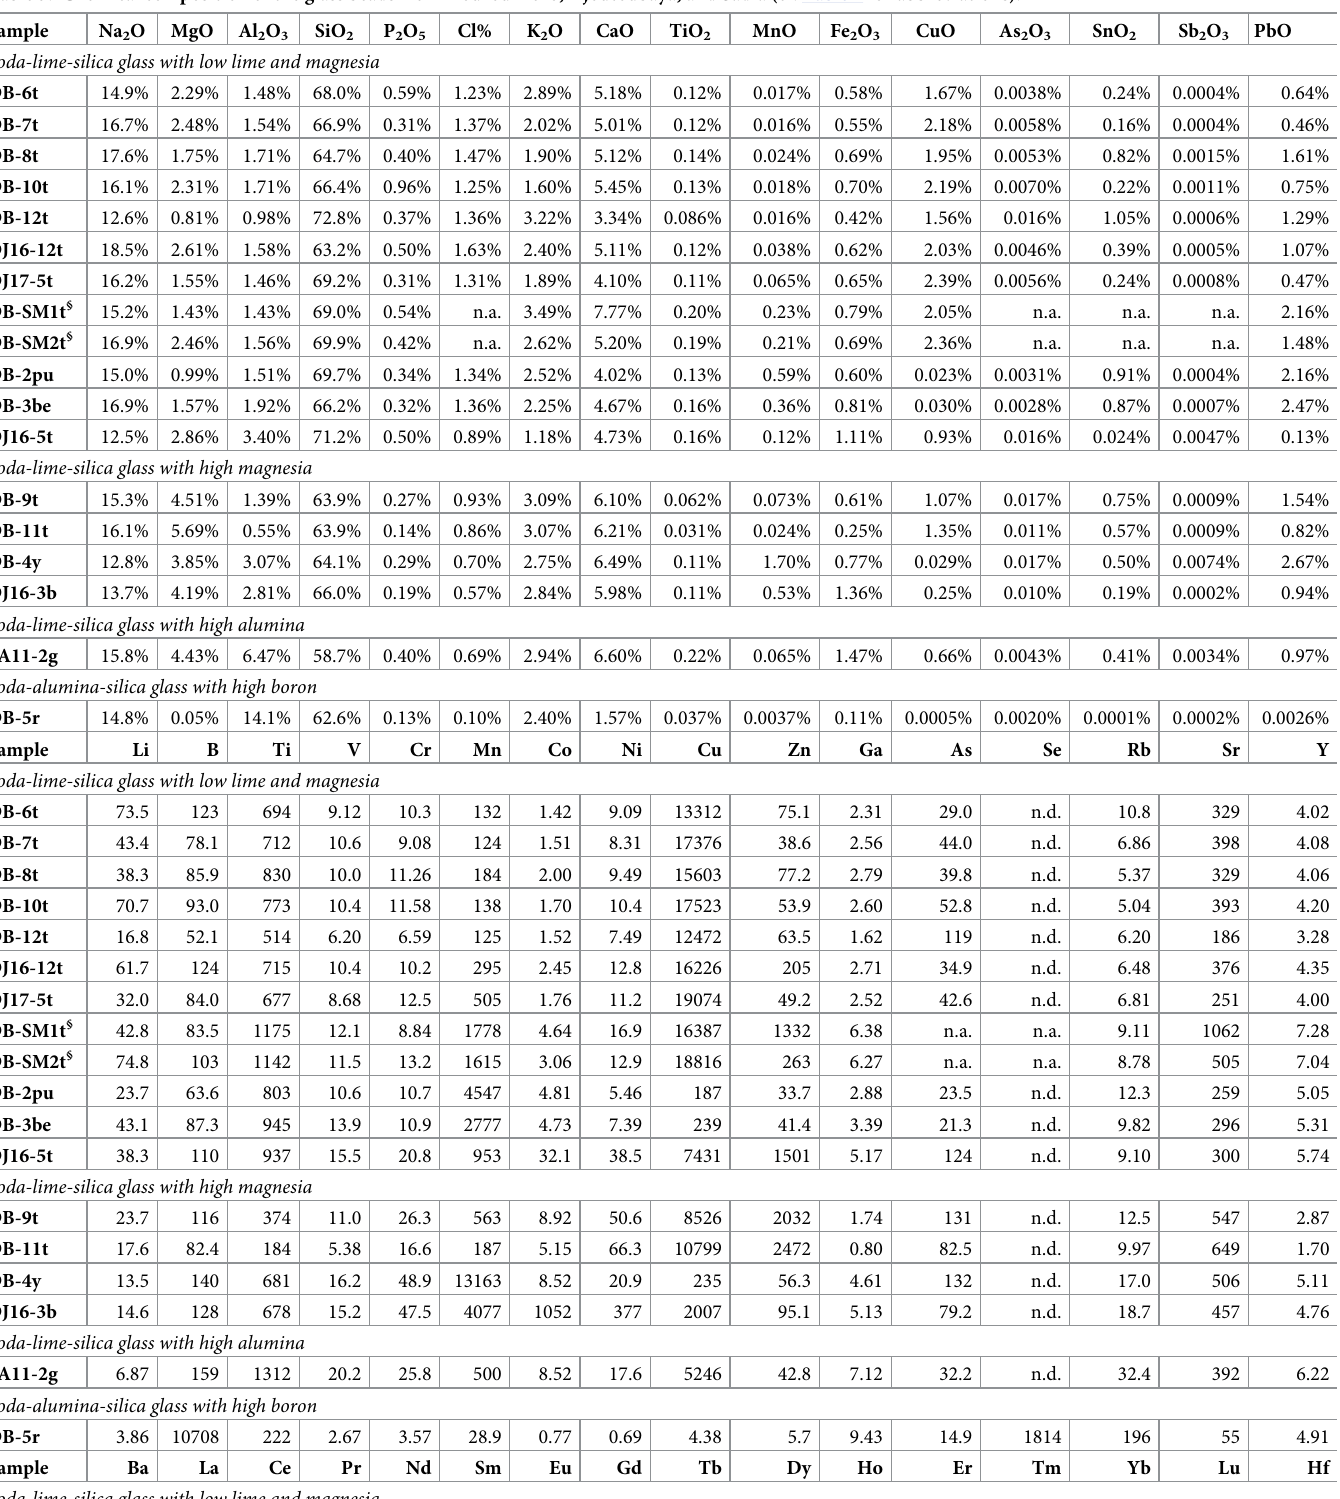
Table 3. Chemical composition of the glass beads from Dourou-Boro, Djoutoubaya, and Sadia (cf. Table 1 for abbreviations).